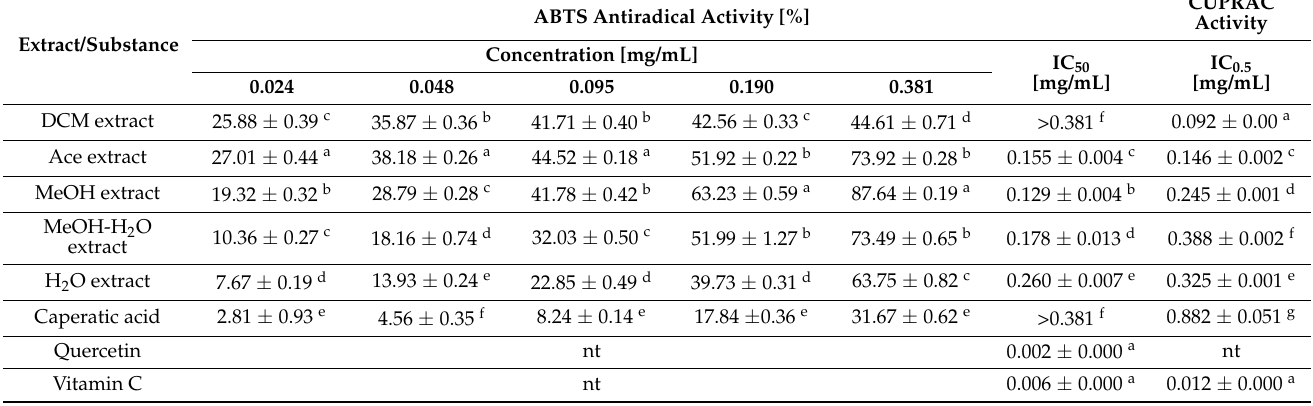
Table 2. Antioxidant activity of lichen extracts, caperatic acid and quercetin and vitamin C as the references measured using ABTS and CUPRAC